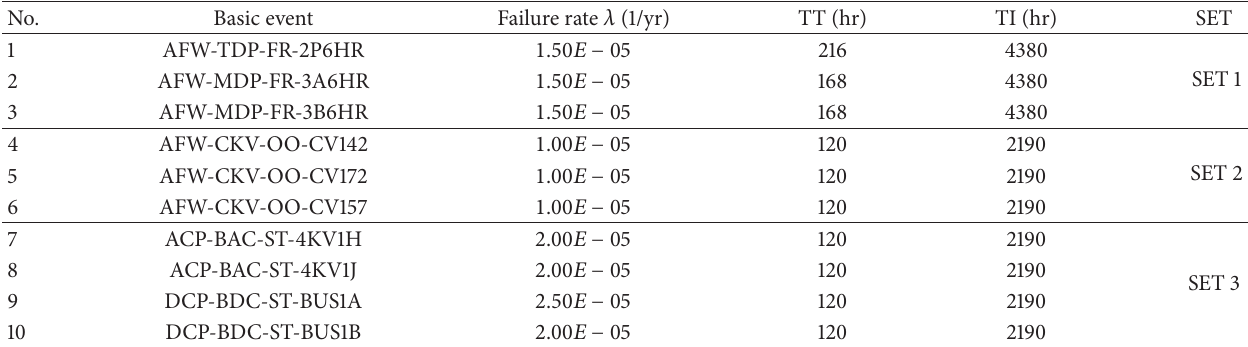
Table 5: Basic events under maintenance in case scenario 2 with corresponding input